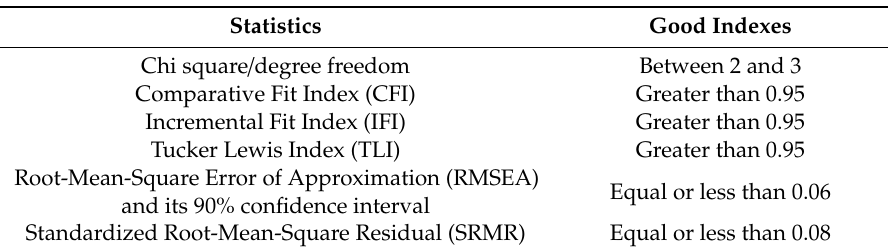
Table 1. Adjustment indexes. Statistics Good Indexes